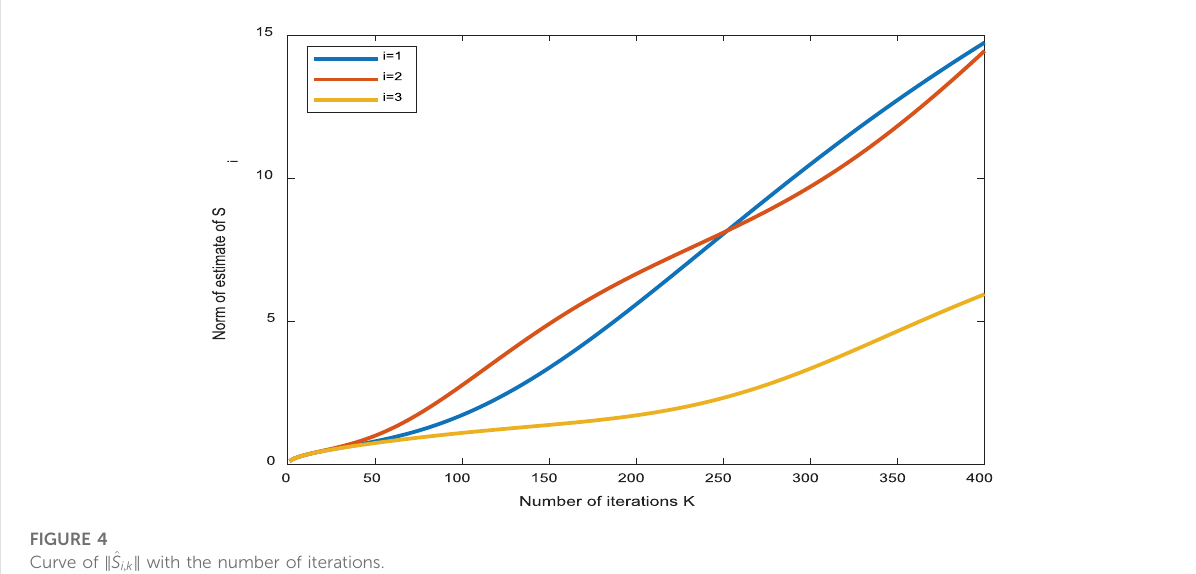
FIGURE 4 Curve of (cid:3) ^ S i , k (cid:3) with the number of